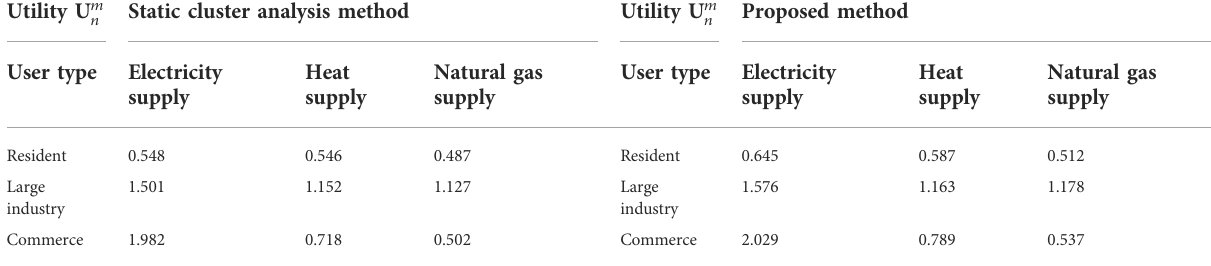
TABLE 2 Users ’ utility results of two